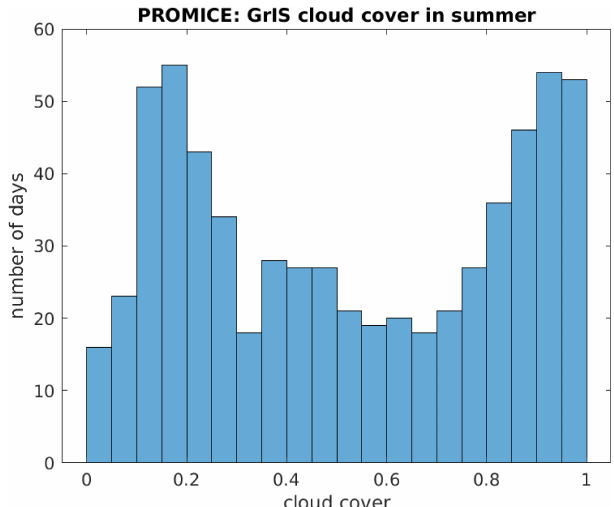
Figure 1. Histogram of daily cloud cover over the Greenland Ice Sheet throughout the summer months (June, July, August) based on daily measurements from up to 11 years of daily observations from 17 PROMICE weather